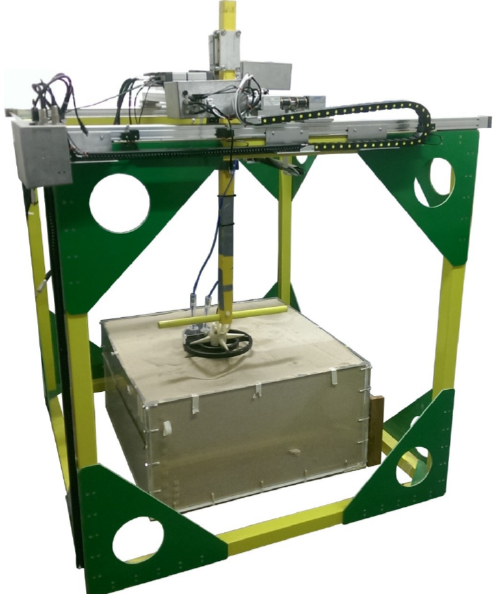
Figure 11. Three-dimensional scanner used for testing.